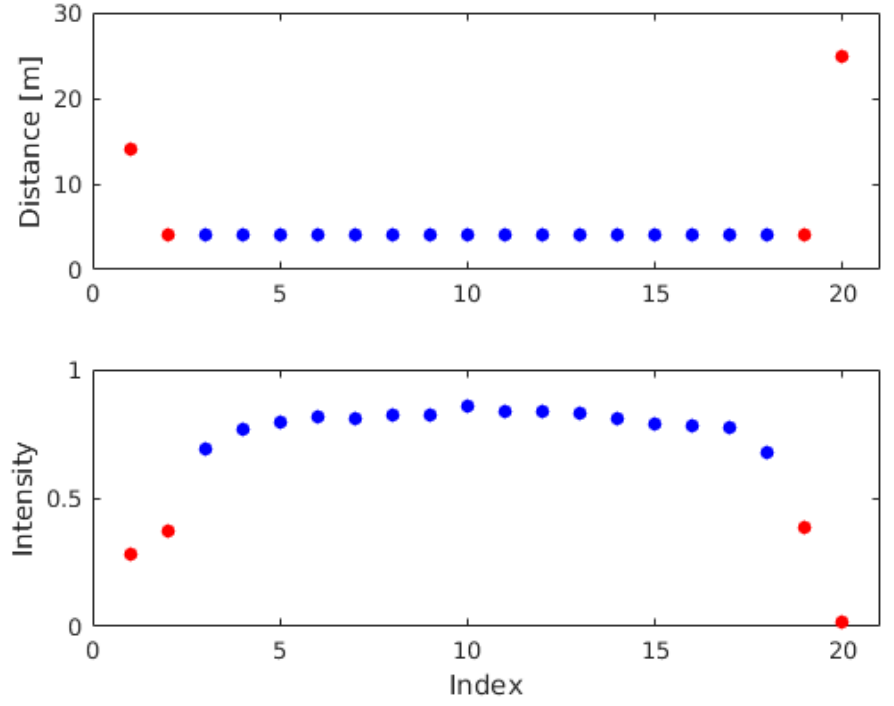
Figure 10. Blue points clustered as stem by intensity, red points as not stem. One point on each flank outside the stem cluster is at the same distance as the stem cluster and should by distance clustering be classified as stem. x -axis: point index in the